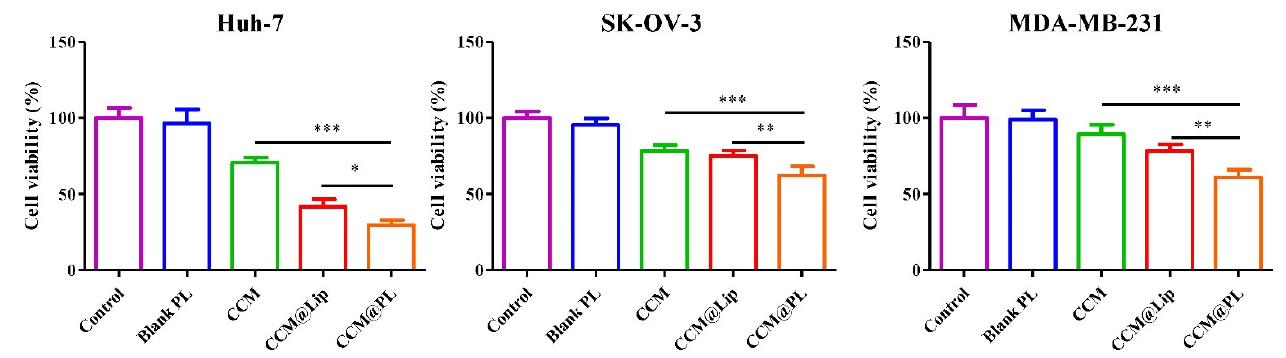
Figure 4. MTT results for Huh-7 cells, SK-OV-3 cells, or MDA-MB-231 cells treated with blank PL, free CCM, CCM@Lip, and CCM@PL. Data are presented as the means ± SDs ( n = 5). * p < 0.05, ** p < 0.01, and *** p < 0.001.